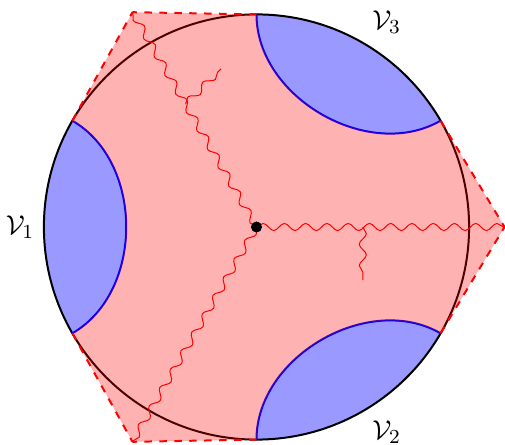
Figure 11. A focusing lightsheet F for the extremal surface configuration sketched in figure 10a. This figure is drawn so that the “future” direction is towards the viewer. The maximin slice sketched in figure 10 is in the background, and the red shaded region is F . The dashed red lines are future- directed light rays on the spacetime boundary that show where F intersects the boundary. Wavy lines are caustics where distinct generators of F intersect one another.